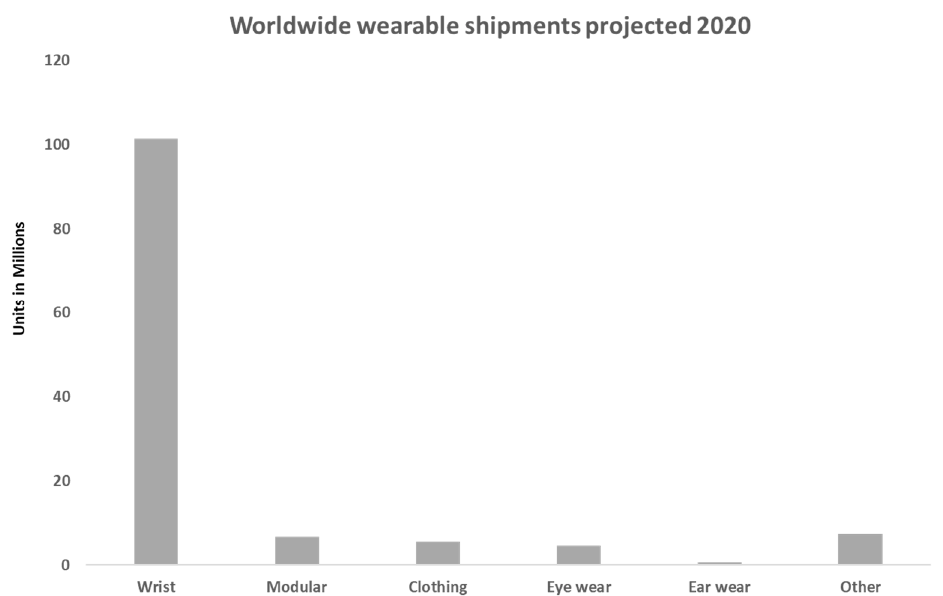
Figure 3. Worldwide wearable shipments projected 2020; data adapted from Statista plot [19]. This figure shows how wrist wear will remain a popular wearable. This could be due to it replacing traditional watches, which consumers have worn for years. If this forecast continues past 2020, then more manufacturers will look to improve on this element alone, but depending on positive consumer feedback, they may even find another body part that can be used for future device placements.